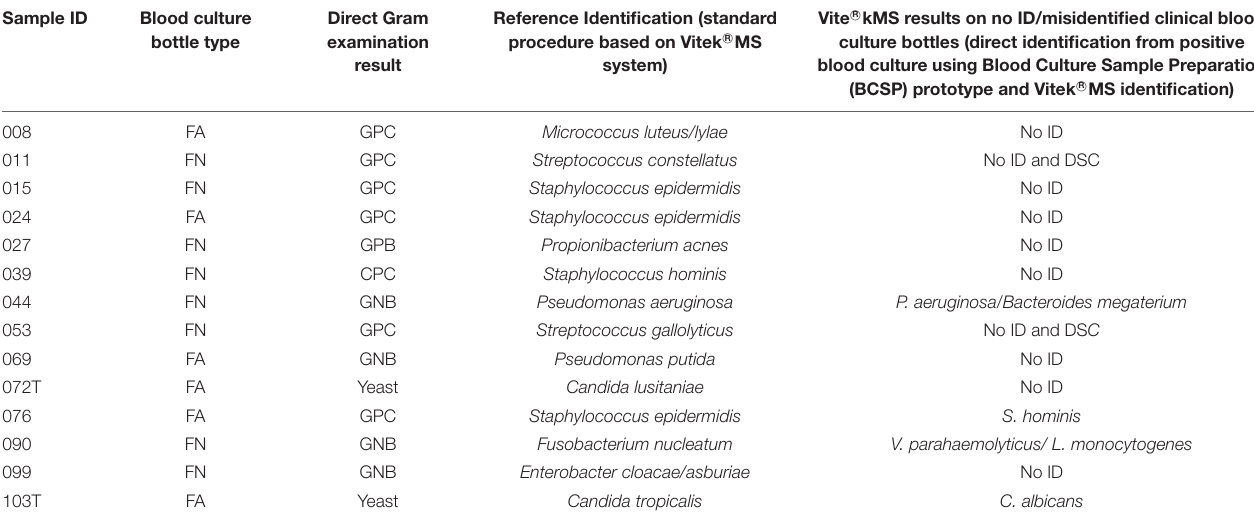
TABLE 3 | Not identified species and discordant results. Sample ID Blood culture bottle type